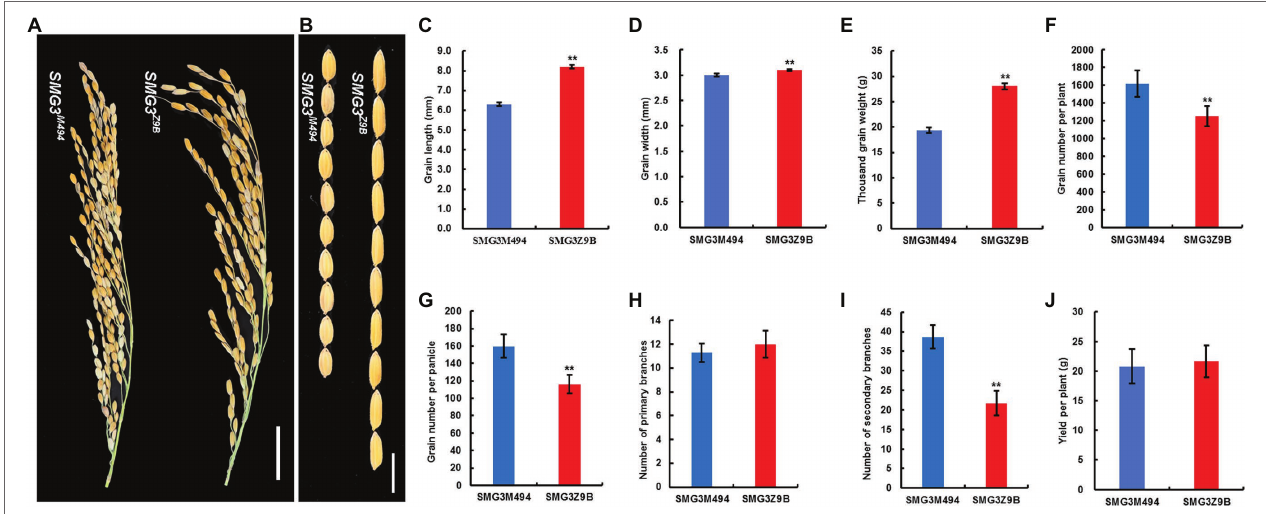
FIGURE 3 | Comparison of the agronomic traits between NIL- SMG3 Z9B and NIL- SMG3 M494 . (A) Panicle phenotype of NIL- SMG3 Z9B and NIL- SMG3 M494 . Scale bar: 3 cm. (B) NIL- SMG3 Z9B and NIL- SMG3 M494 rice grains. Scale bar: 8 mm. (C–J) Grain length (C) , grain width (D) , thousand grain weight (E) , grain number per plant (F) , grain number per panicle (G) , number of primary branches (H) , number of secondary branches (I) , and yield per plant (J) of NIL- SMG3 Z9B and NIL- SMG3 M494 . Data are given as means ± SD. ** Indicates p < 0.01 by Student’s t -test.